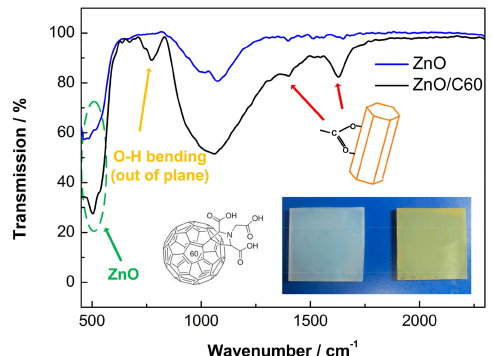
Figure 2. FTIR spectra of the ZnO NRAs with or without graft of C60 pyrrolidine tris-acid; the left inset shows the molecular structure of C60 pyrrolidine tris-acid, and the right inset shows the optical image of the ZnO NRAs before and after